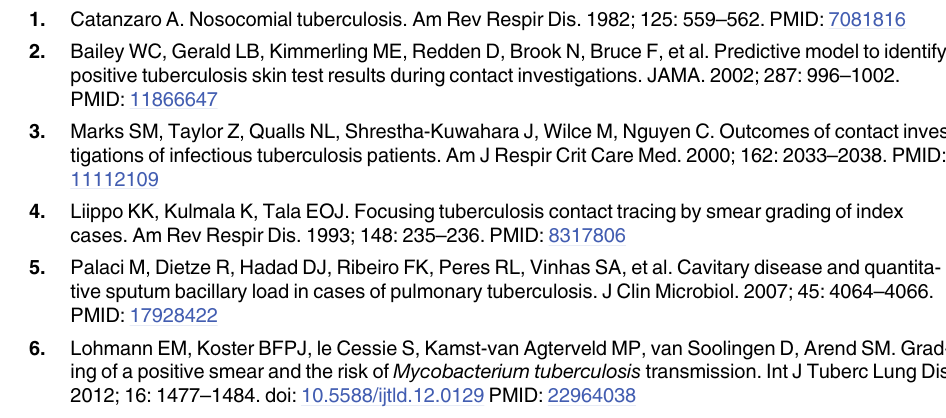
S1 Fig. Data abstraction form. Data abstraction form and dictionary used to categorize patients as being typical (post-primary) or atypical (primary or